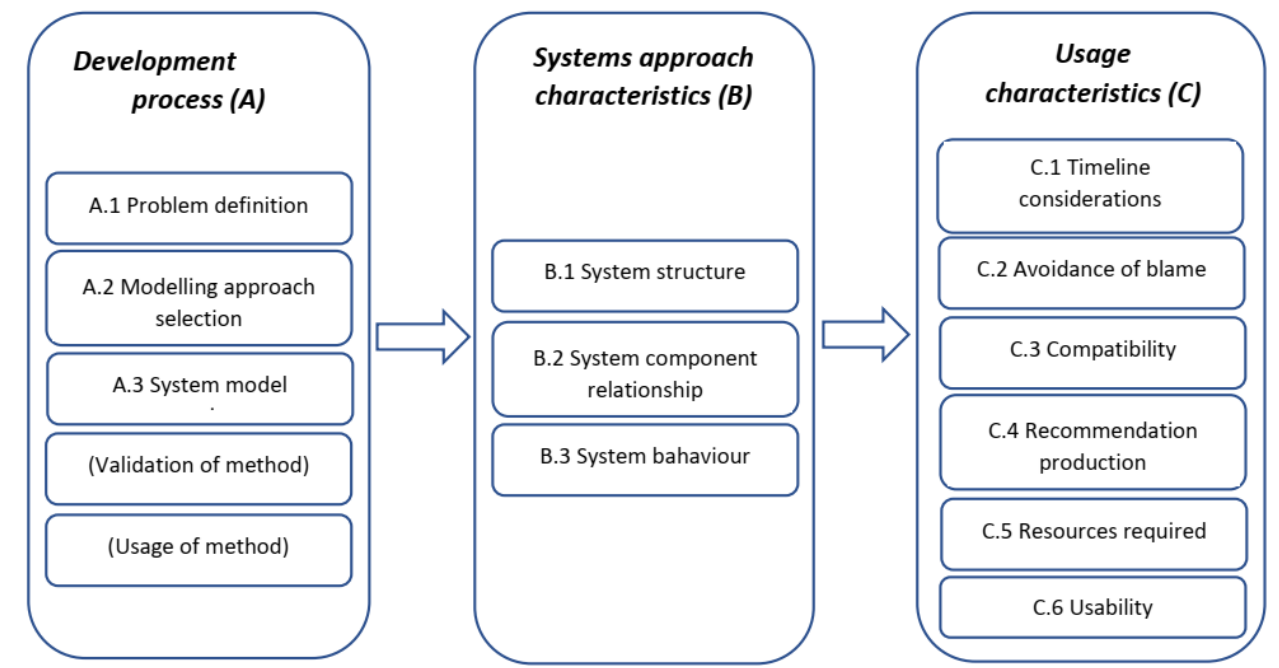
Figure 3. The evaluation framework adapted after Underwood [7].